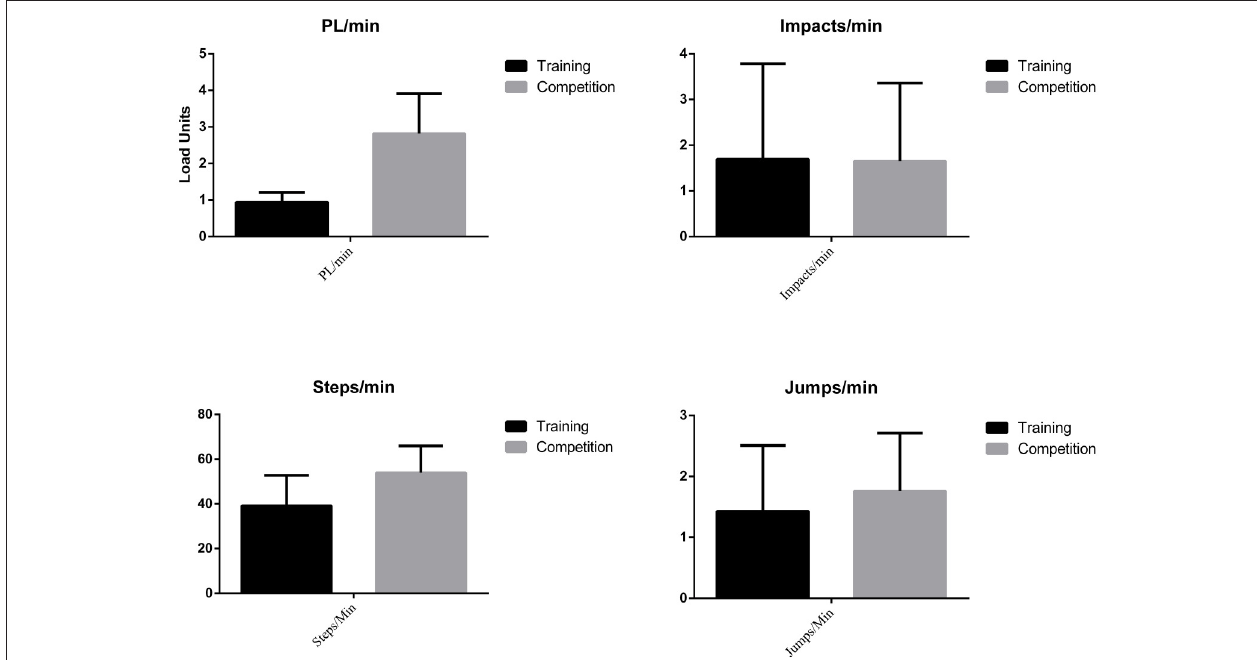
FIGURE 4 | External load by Game